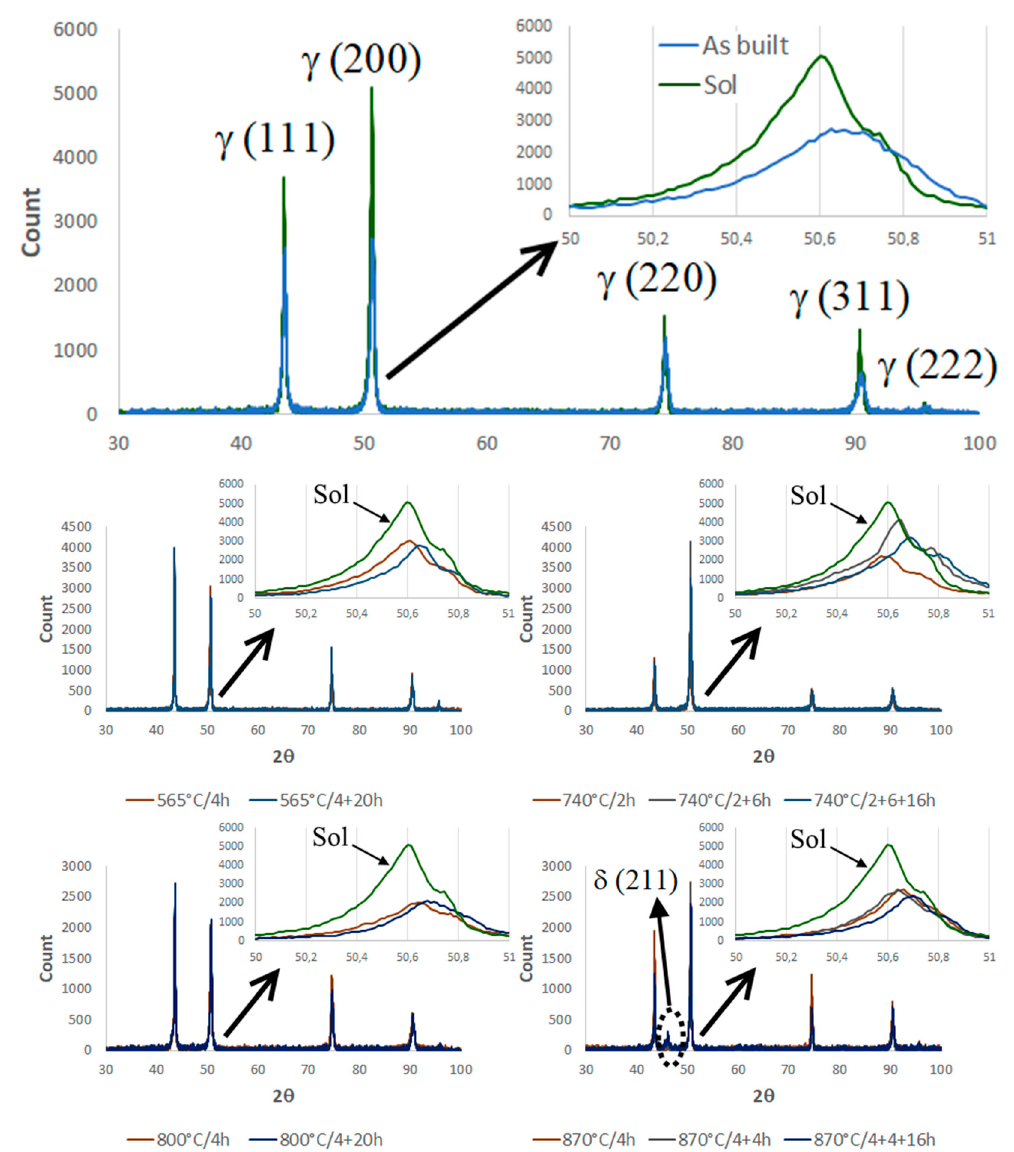
Figure 20. X-Ray di ff raction (XRD) spectra acquired from SLM Inconel 718 samples at di ff erent heat treatment conditions (as-built, solutioning, and aging at di ff erent temperatures and times). The γ (200) Figure 20. X-Ray diffraction (XRD) spectra acquired from SLM Inconel 718 samples at different heat peak is shown in higher treatment conditions (as-built, solutioning, and aging at different temperatures and times). The γ (200) peak is shown in higher resolution.